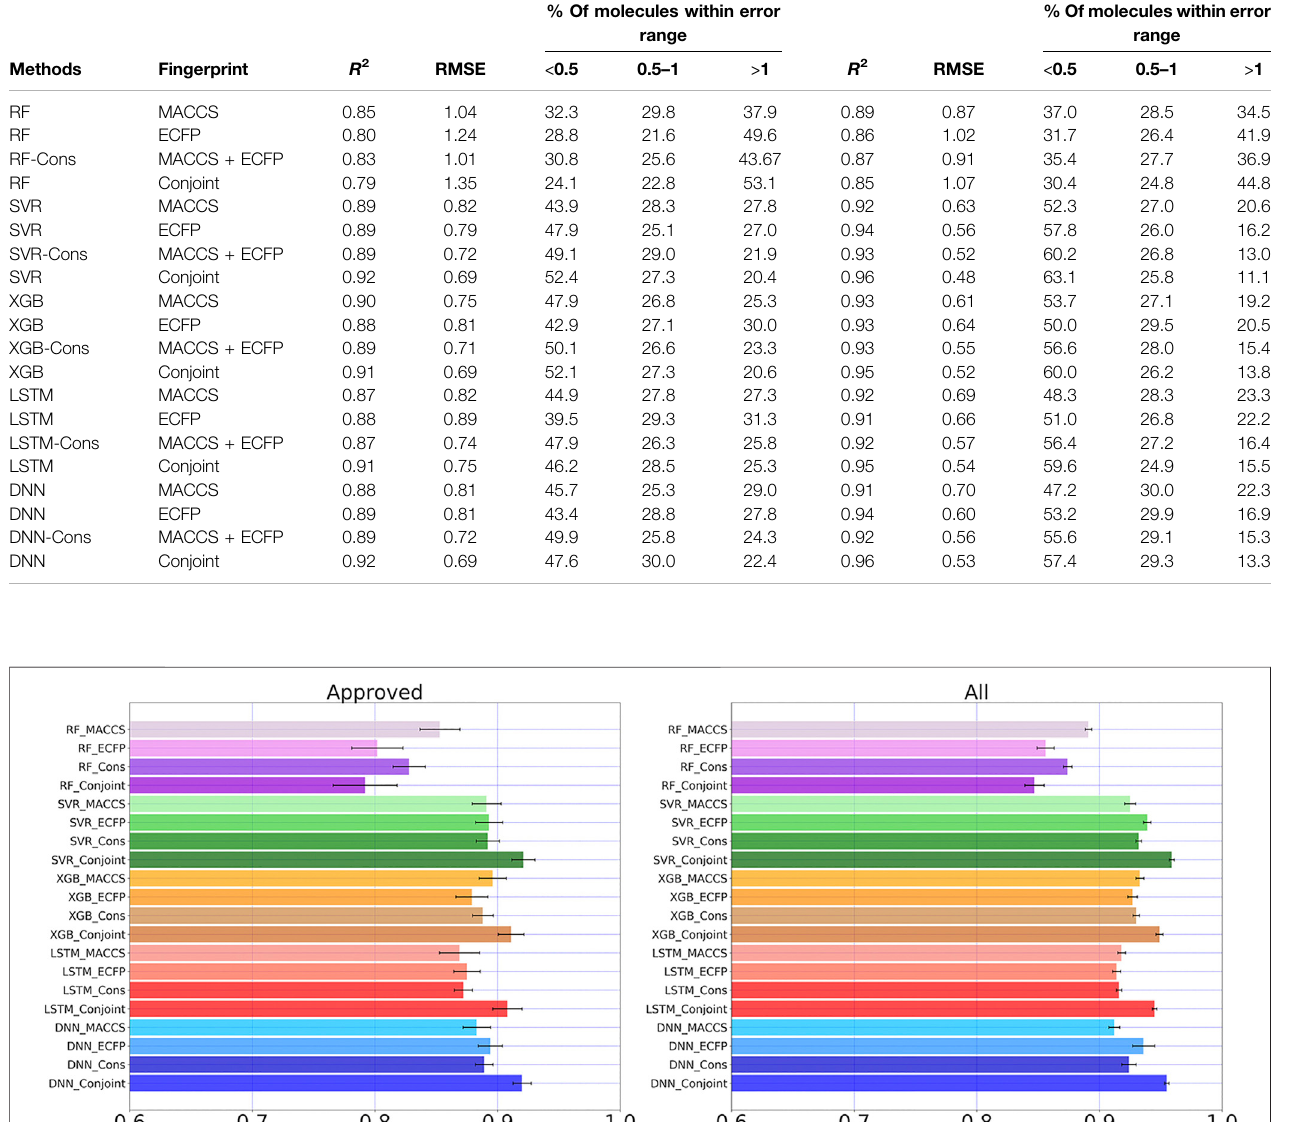
TABLE 1 | Root mean square error and distribution for each validated fi ngerprints. Approved All